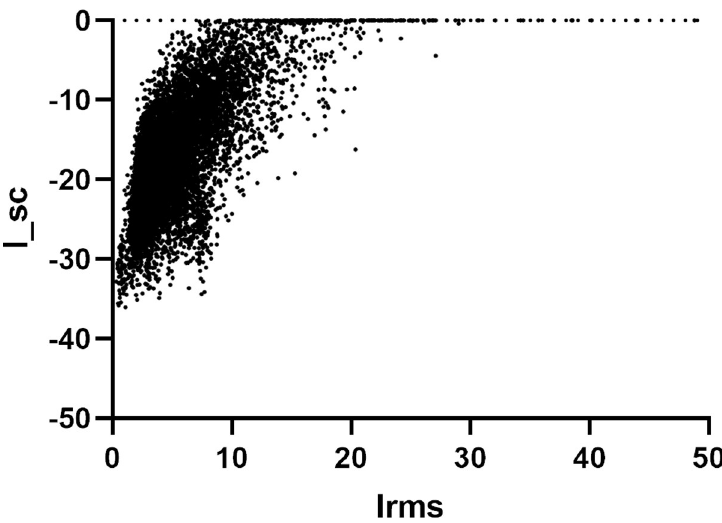
Fig 3. Plots of interface energy (I_sc) against interface root mean square error (I_rms). Each point represents a complex formed from one of the top 5 ZDock outputs of VKORC1 and ORF7a proteins, using 10,000 decoys. All plots form energy